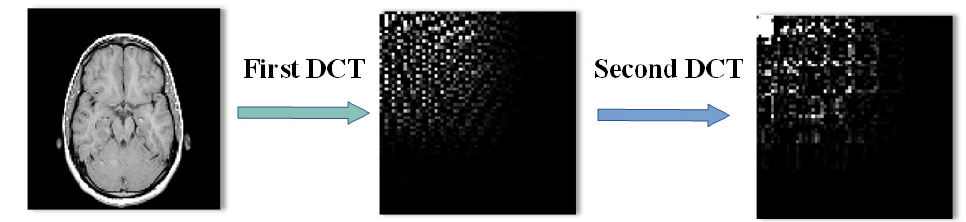
Figure 2. DCT coefficient frequency distribution diagram.